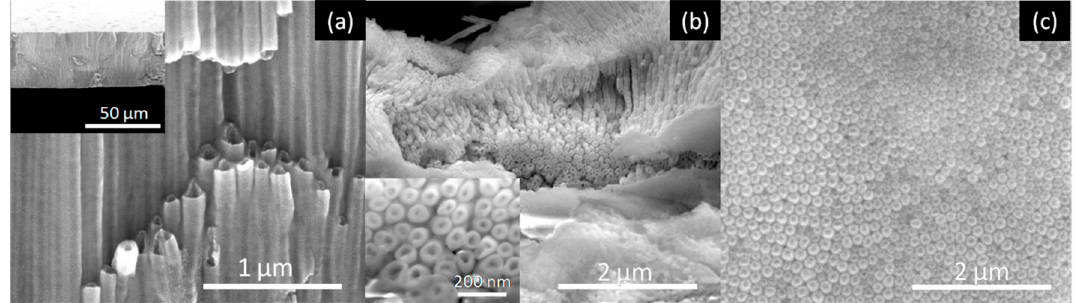
Figure 7. SEM images of the AHO NTs after 1 h of anodization for the DMSO sample: ( a ) Cross-section view (inset at lower magnification), ( b ) top view (inset at higher magnification) and ( c ) bottom view.